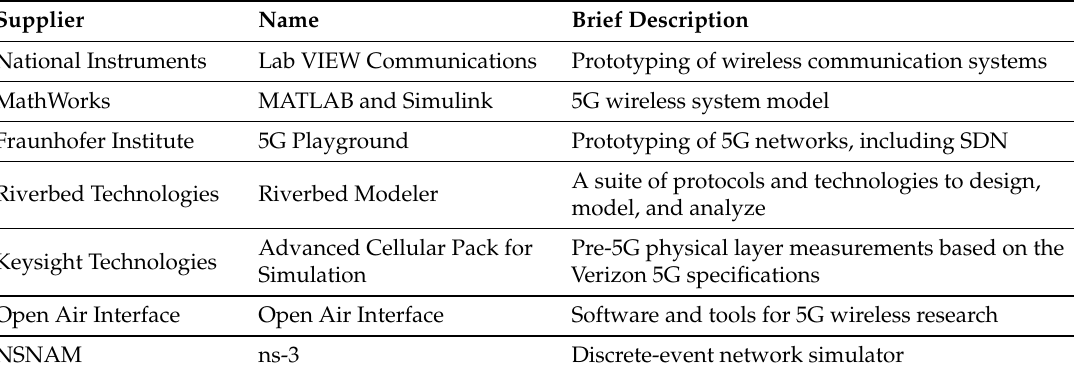
Table 2. Tools and frameworks for prototyping and